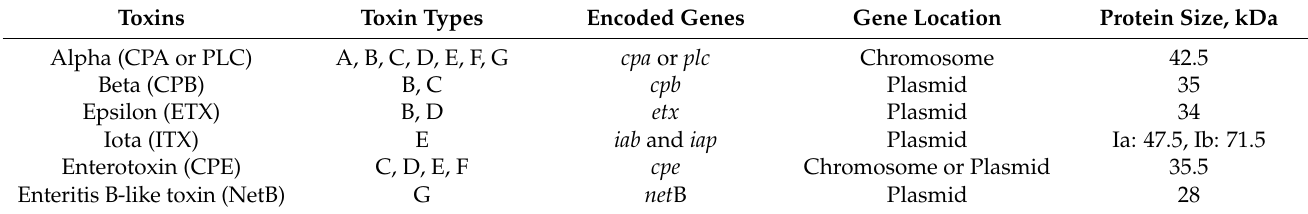
Table 1. Main toxins produced by C. perfringens and their